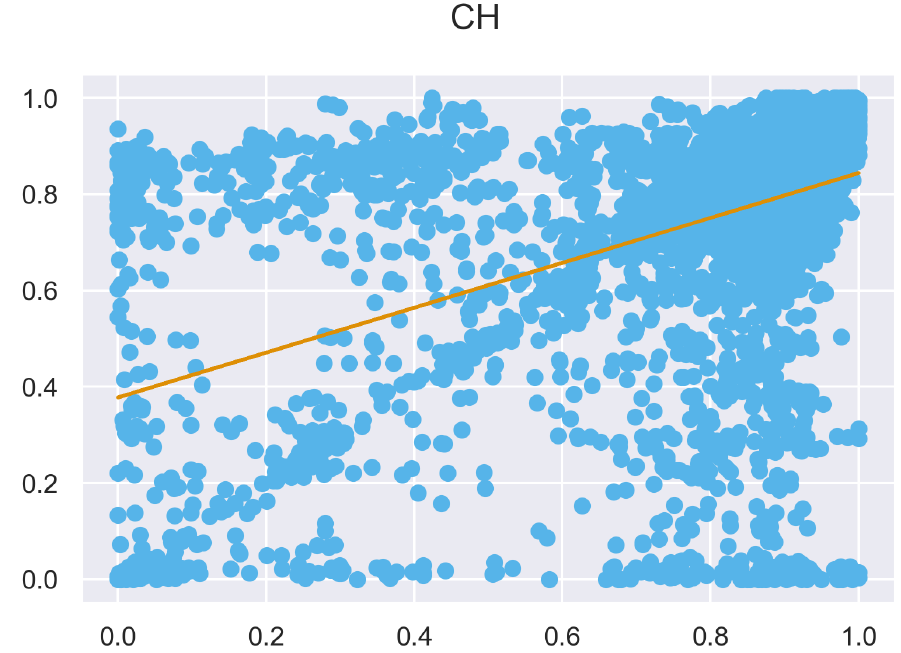
Figure A27. ULS and TLS CH regression at 1m grid